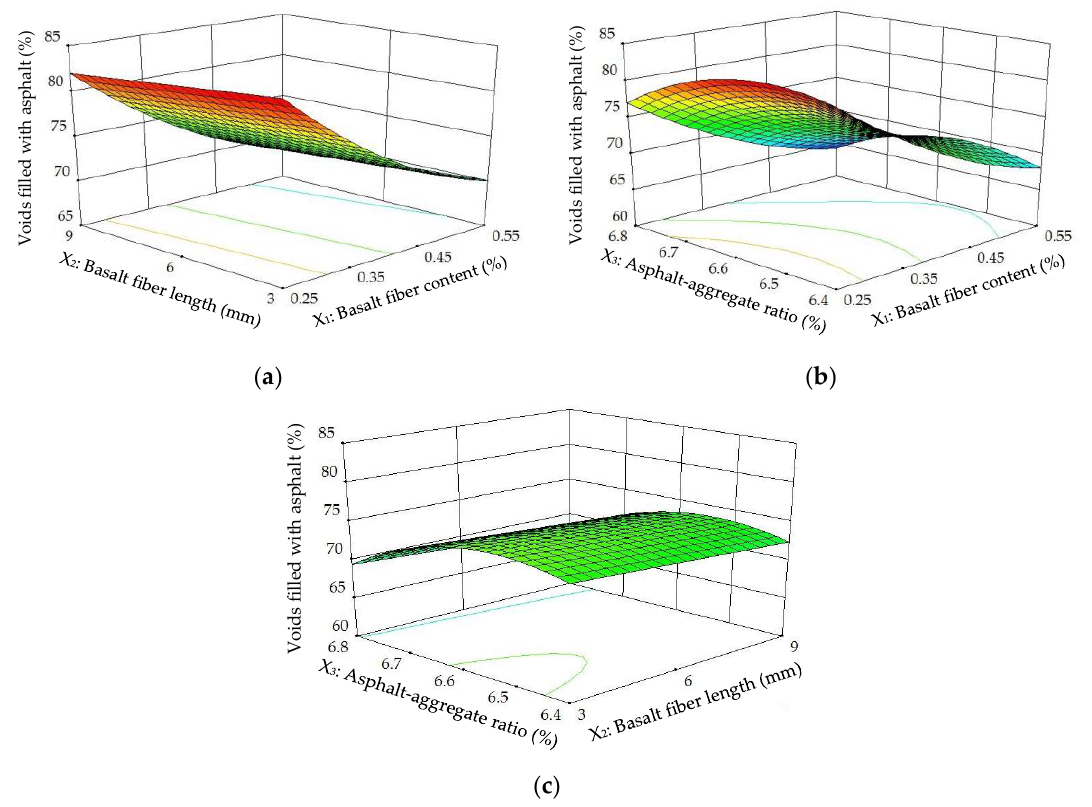
Figure 15. Response surface plots between VFA and factors: ( a ) Factors: BFC and BFL at AAR = 6.6%; ( b ) Factors: BFC and AAR at BFL = 6 mm; ( c ) Factors: BFL and AAR at BFC = 0.4%.